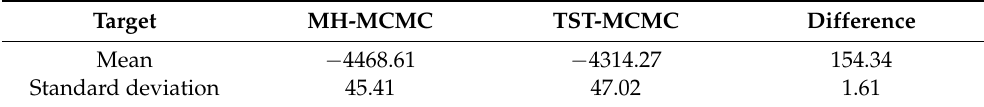
Table 2. The mean value and the standard deviation of the best likelihood value of 50 experimental